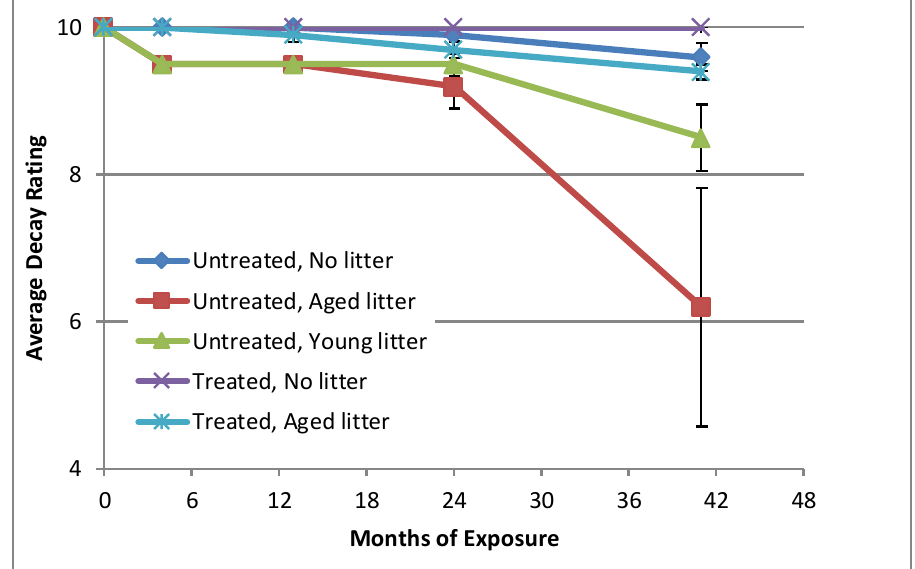
Figure 4. Average decay rating ( n = 5) of above-ground wood samples in di ff erent exposure